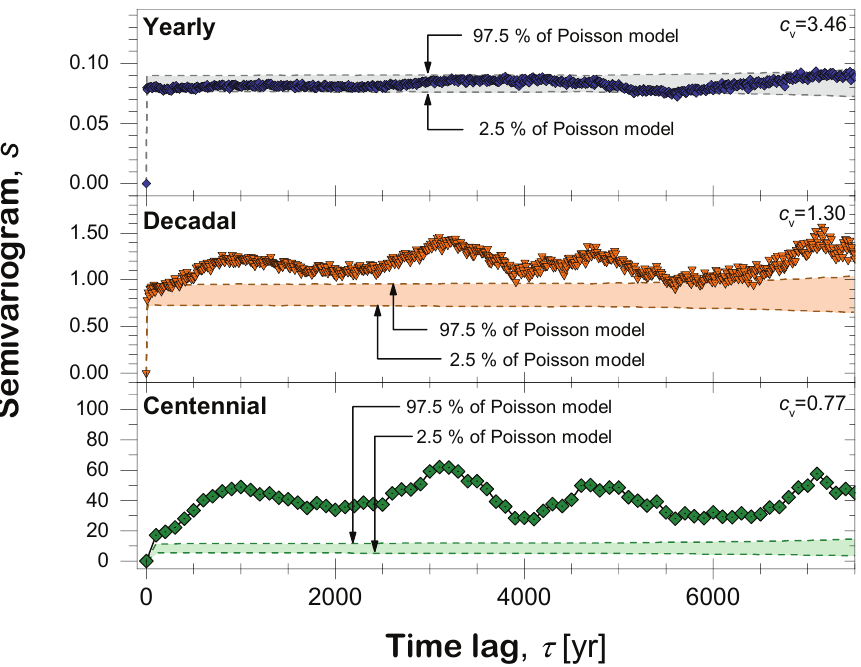
Figure B1. Semivariogram (Eq. B1) of the three palaeoflood time series, n year , n decade and n century for lags 0 ≤ τ ≤ 7500 years. Also shown is the 95% range of the semivariogram of the best-fitting Poisson model (see Sect.